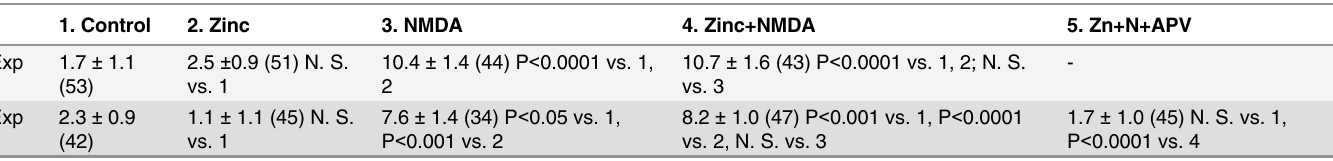
Table 1. Changes in index of curvature of PSD a